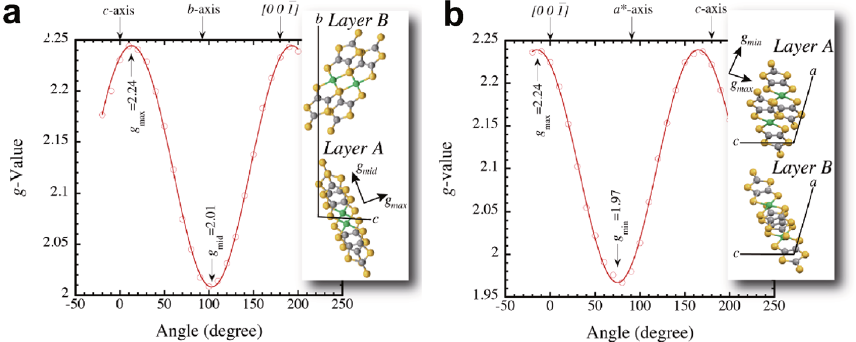
Figure 4. The angular dependence of the g -value. The g -value anisotropies of (Et-4BrT)[Ni(dmit) 2 ] 2 in the layer ( a ) bc -plane and ( b ) a * c -plane measured from the angular dependence of ESR at 4 K. The a *-axis is the axis perpendicular to the bc -plane. The insets show the relations between the observed principal axes of the g -tensor and the molecular arrangements of the dimer in layer A and B. The principal axes ( g max , g mid and g min ) coincide with the short, long and vertical axes of the dimer in layer A,